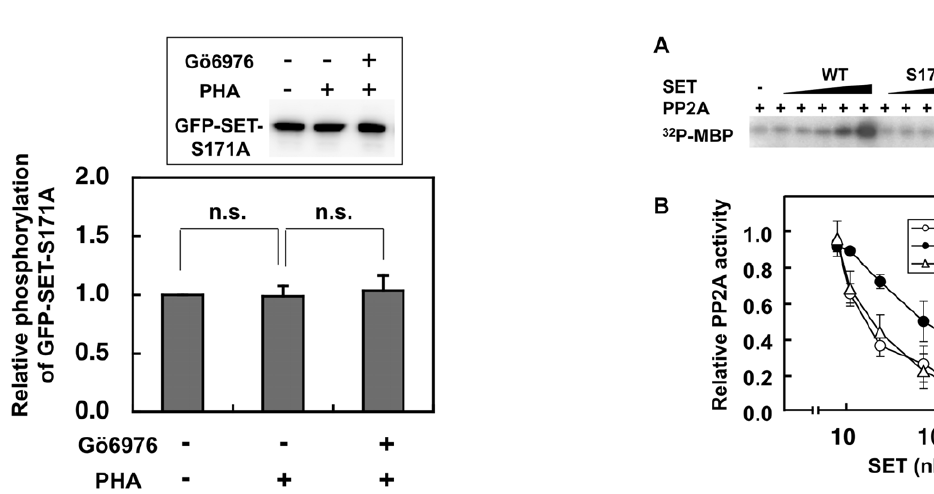
Figure 4. Phospho-GFP-SET-S171A levels in Jurkat were unchanged by PHA stimulation with or without PKD2 inhibitor. The Jurkat cells expressing GFP-SET-S171A were stimulated and phosphorylation status of GFP-SET-S171A was investigated by the same method as described in Fig. 2. The results were indicated as mean + SD for three independent experiments. There was no significant up- or down-regulation of recovered phospho-GFP-SET-S171A by PHA stimu- lation with or without PKD2 inhibitor, suggesting that Ser171 of SET is the major target site of TCR-activated PKD2.